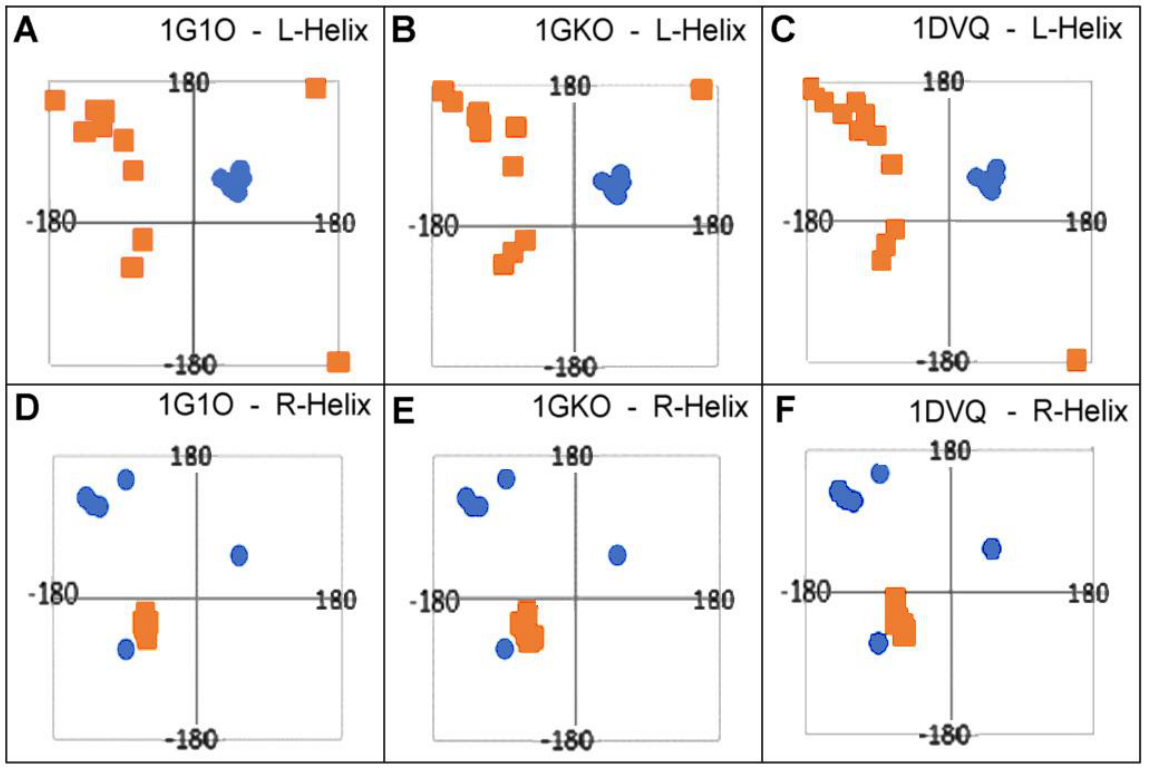
Figure 7. The migration of Phi, Psi angles as compared in native and amyloid forms of transthyretin. ( A – C )—The amino acids of L-handed α -helix conformation in amyloid (blue circles) migrated from the positions shown as orange squares in native form. ( D – F )—The amino acids of R- α -helix in the native form (orange squares) migrated to positions in amyloid (blue circles).